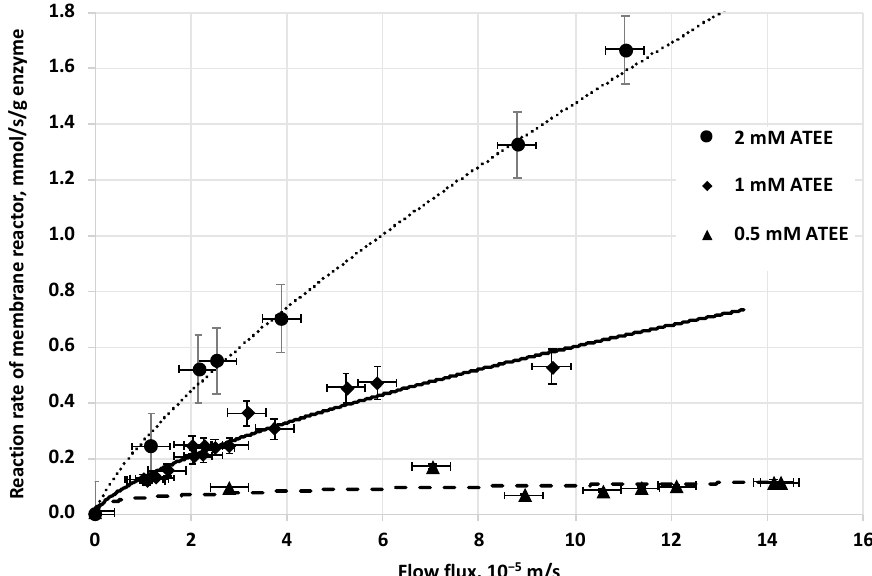
Figure 5. Reaction rate values of biocatalytic membrane reactor in the function of convective flow across the membrane. Results show that the reaction rate is increasing by increase of the convective flow rate across the biocatalytic membrane layer. (Standard error values are plotted. They have varied between ±4 and 6% of measured mean values.)